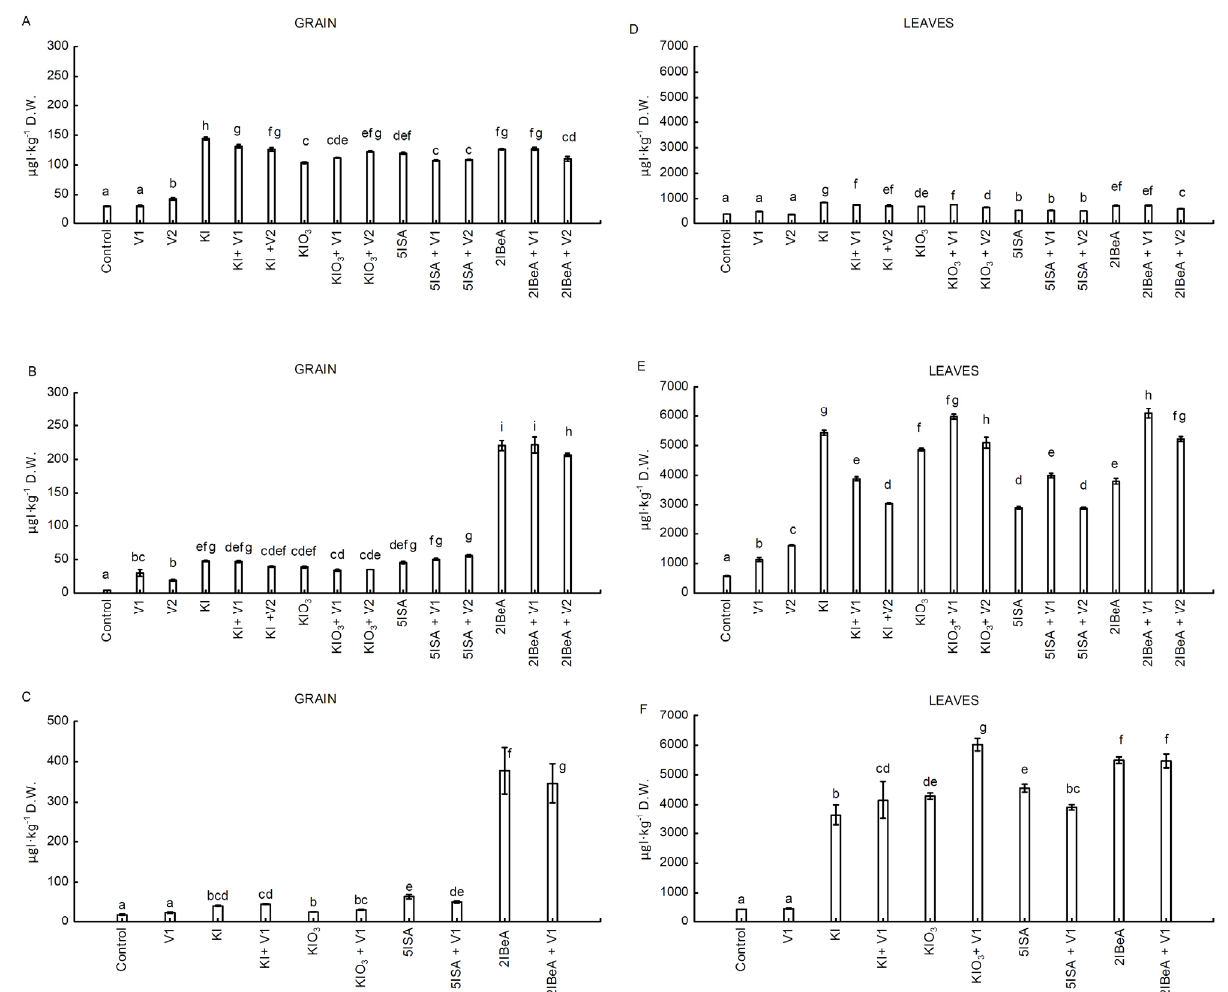
Figure 1. Iodine contents in grain in experiment No. 1 ( A ), No. 2 ( B ) and No. 3 ( C ) and in leaves in experiment No. 1 ( D ), No. 2 ( E ) and No. 3 ( F ) of sweetcorn plants. Means followed by different letters for treatments differ significantly p < 0.05 ( n = 8). Bars indicate standard error.